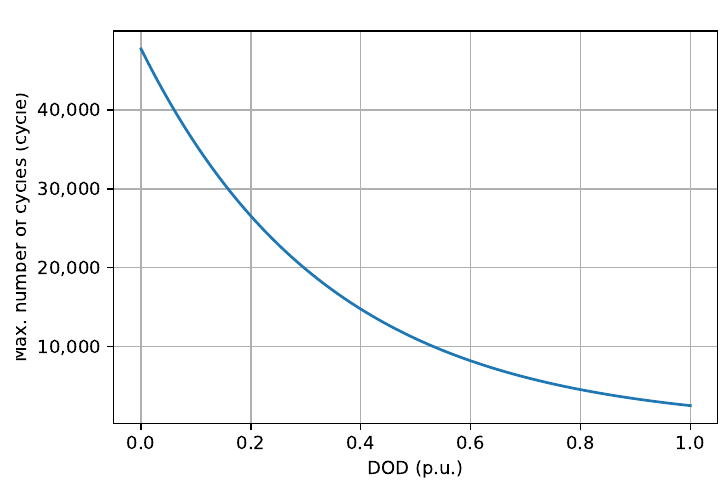
Figure 1. Degradation curve of Li-ion BESS, based on [24].